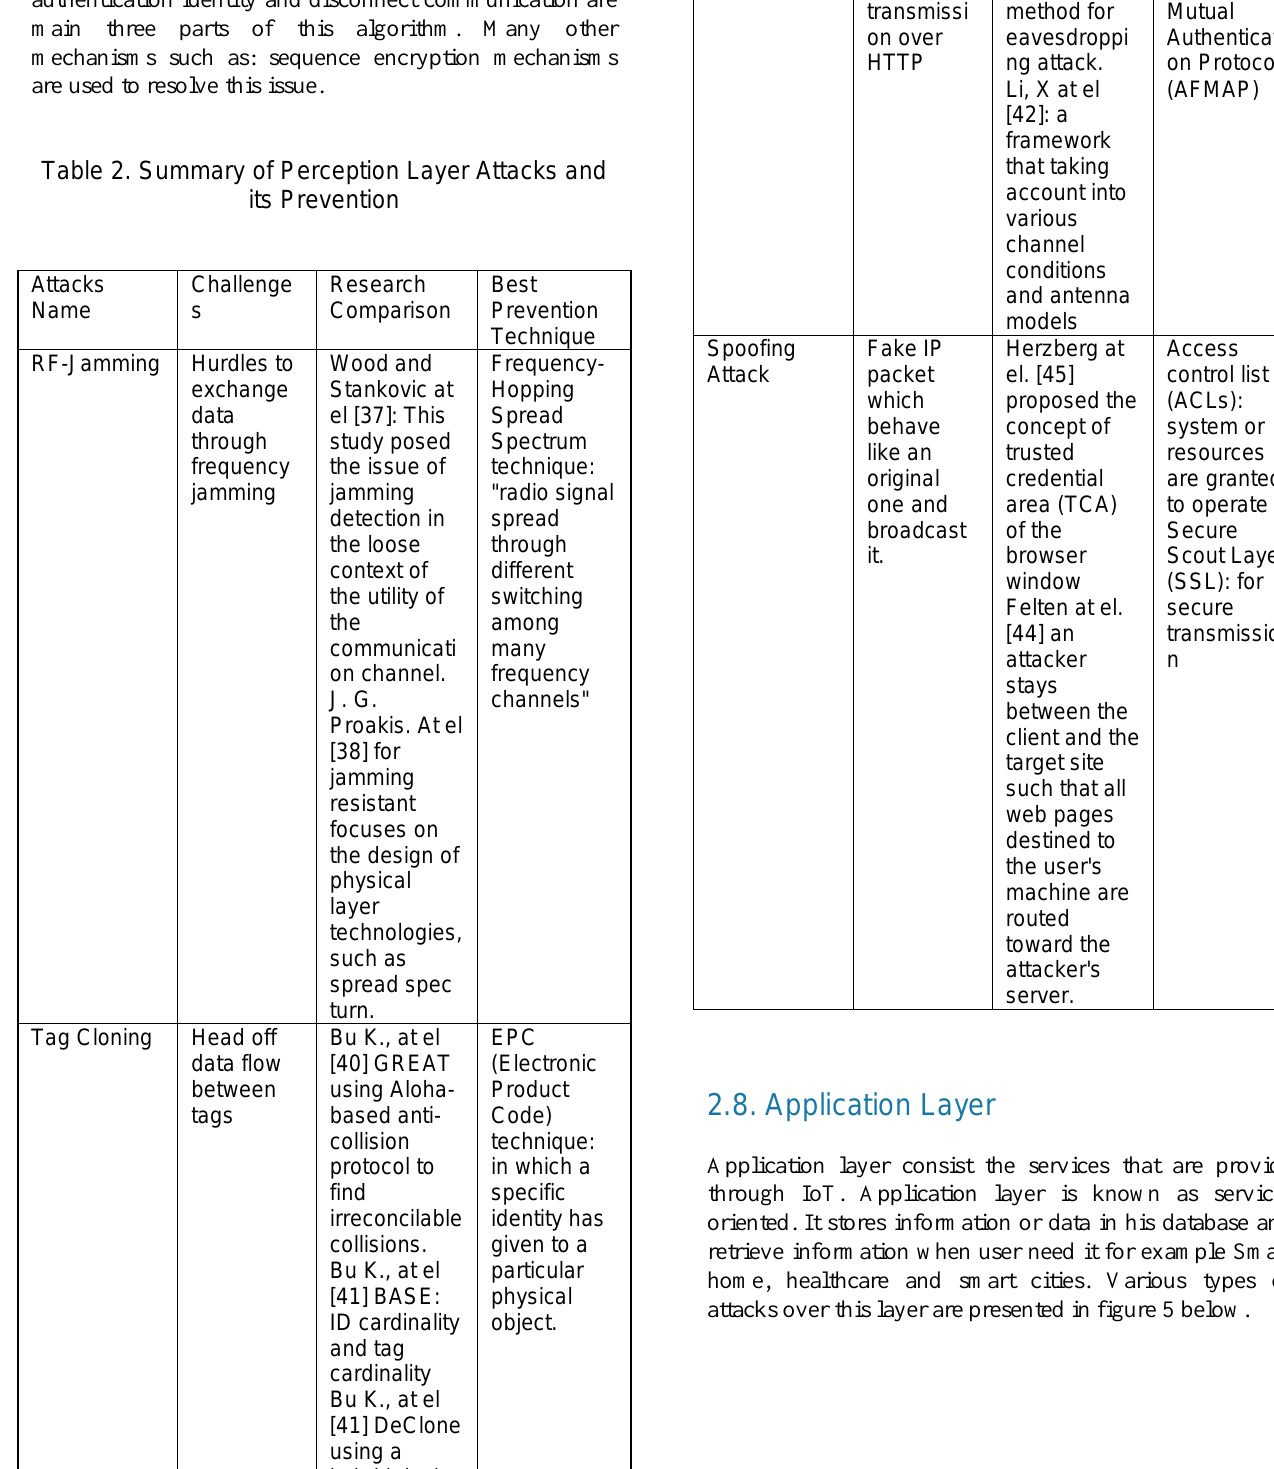
attacks over this layer are presented in figure 5